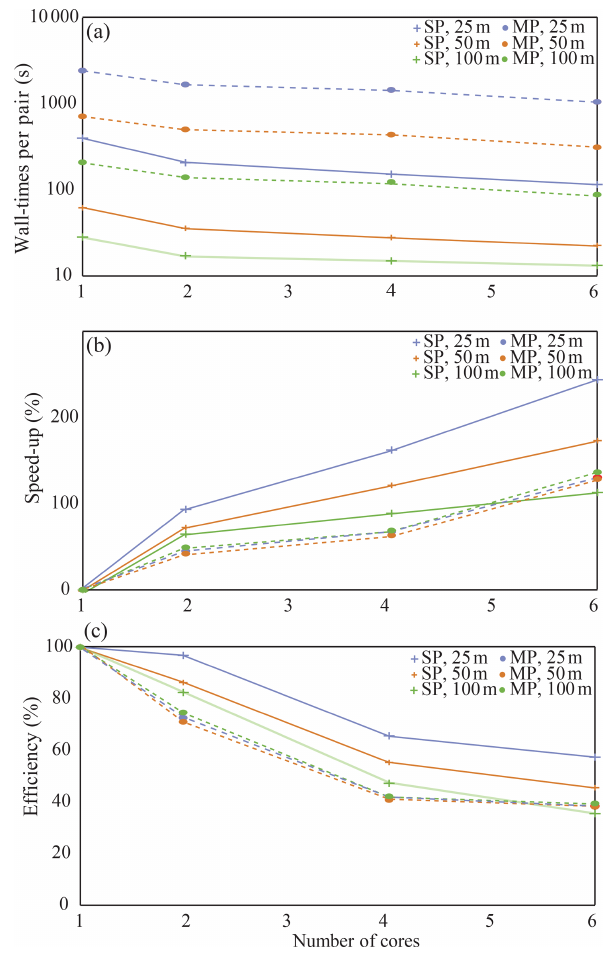
Figure 3. MP = multi-pass; SP = single-pass. Test conducted on a 12-image dataset of 10m resolution, 1.7 million pixel images of Amalia Glacier, Chile, using a Dell XPS 15 laptop (2 × 16GB DDR4 2666MHz memory, 6-core Intel i7-8750H 2.20GHz proces- sor). In all cases, parallelization decreases runtime, and going from one to two cores improves runtime by 1.4–1.9 × . Fine-resolution multi-pass runs usually yield the best velocity fields, and (b) shows that these benefit from the largest speed-up when